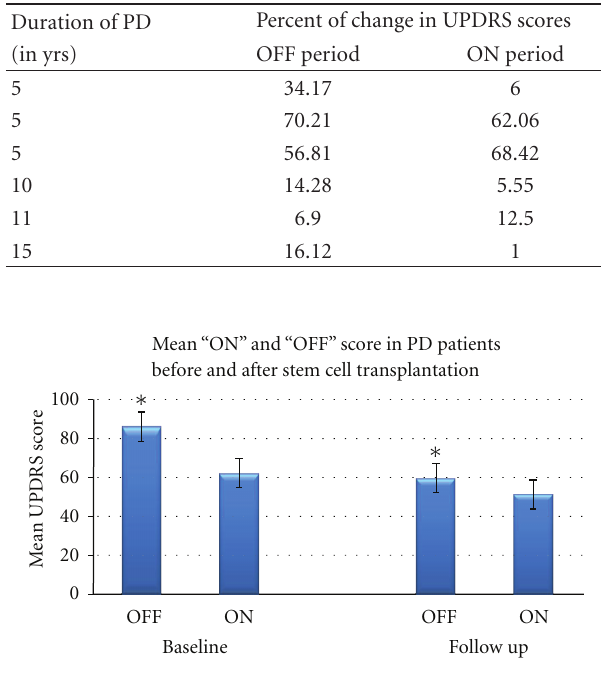
Figure 2: Shows the mean ± SD of the UPDRS score of the PD pa- tients during “OFF” and “ON” periods at baseline and after stem cell transplantation. The scores have been assessed during the screening visit and final visit 12 months after transplantation. ∗ Rep- resents the level of significance.